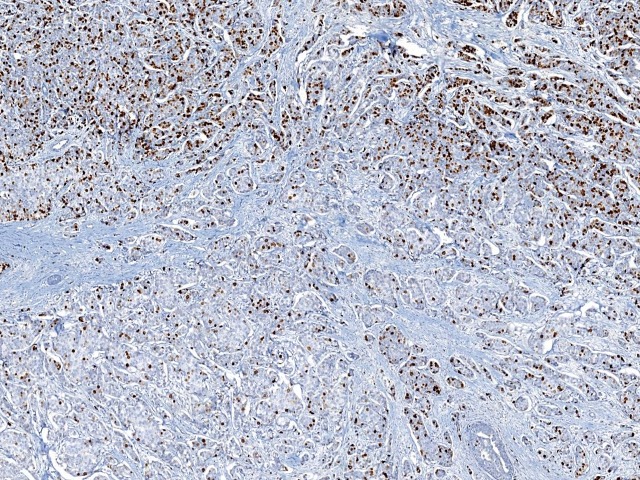
A heterogeneously stained case of Ki67.Ki67 LI was high in upper areas and low in lower areas.